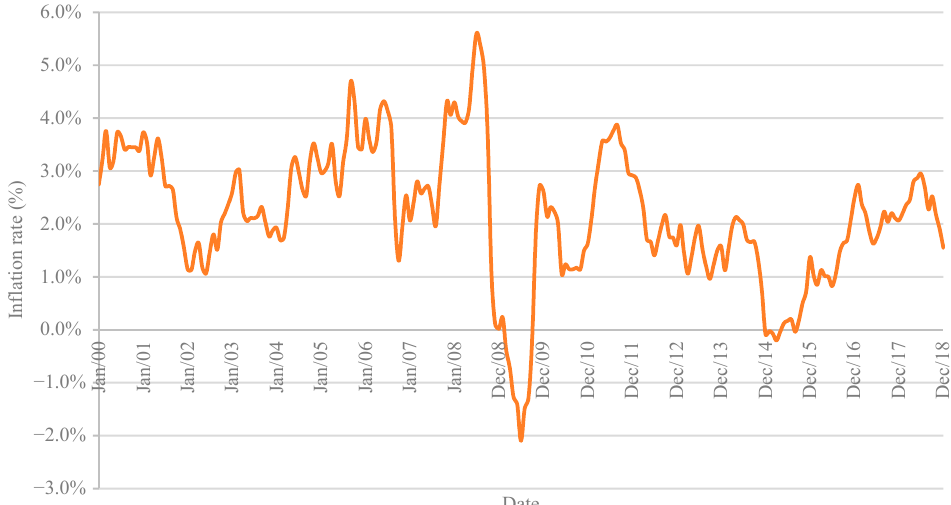
Figure 3. U.S. Year-on-year Consumer Price Index Rates.